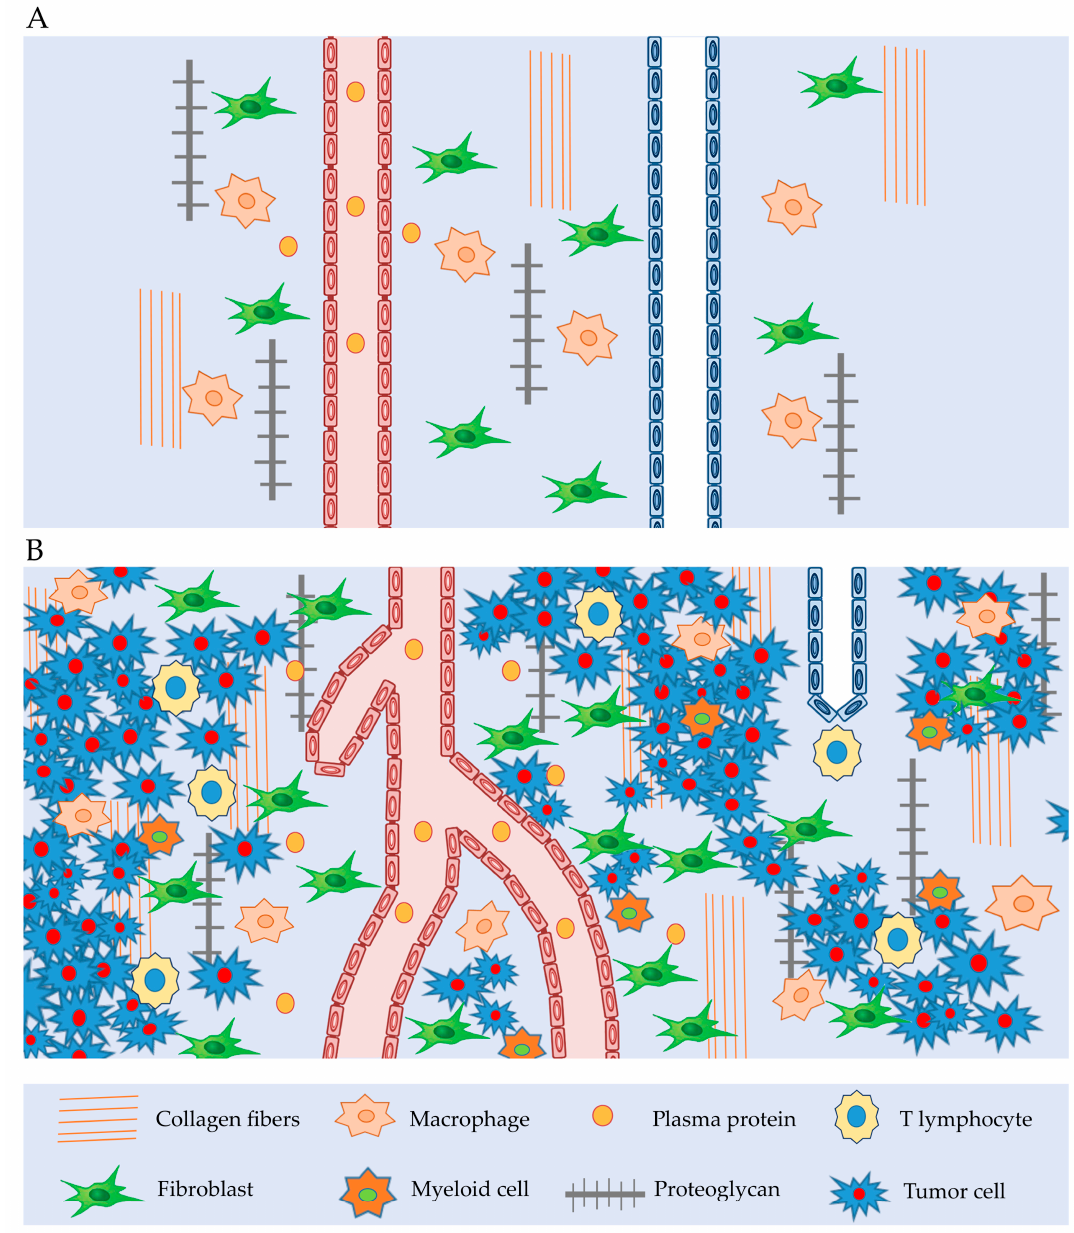
Figure 1. Interstitium tissue: ( A ) Normal interstitium tissue with lymphatic and blood vessel, macrophages, fibroblast, collagen fibers, proteoglygan. ( B ) Tumor interstitium tissue with reduced lymphatic vessel, winding blood vessel, macrophages, fibroblasts, increased amount of extravasated plasma proteins, T-lymphocyte, myeloid cells, collagen fibers, proteoglygan and tumor cells, all of which induce to an increase in tumor interstitial pressure.